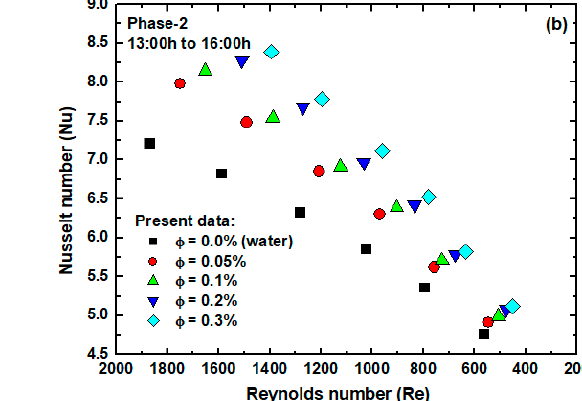
Figure 12. The hybrid nanofluids heat transfer coefficient; Phase-1 ( a ), and Phase-2 ( b ). The heat transfer coefficient is further improved by 10.16%, 18.92%, 23.23%, and 26.33% at 0.05%, 0.1%, 0.2%, and 0.3% volume concentrations and Re of 562, 544, 506, 476, and 435, respectively over water data. The next correlations were developed for Nusselt number. Phase-1: Nu = 0.1015Re (cid:2868).(cid:2873) Pr (cid:2868).(cid:2872) (1 + 𝜙) (cid:2868).(cid:2875)(cid:2874)(cid:2869)